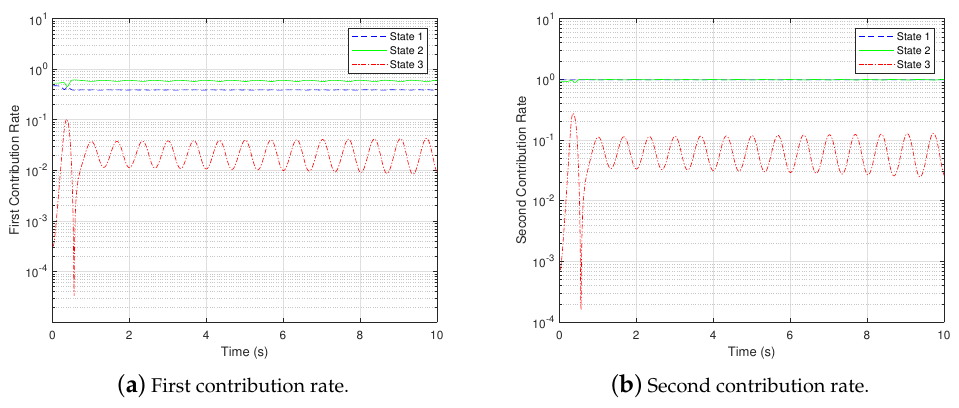
Figure 6. gPC-based observability Gramian analysis: contribution rates.